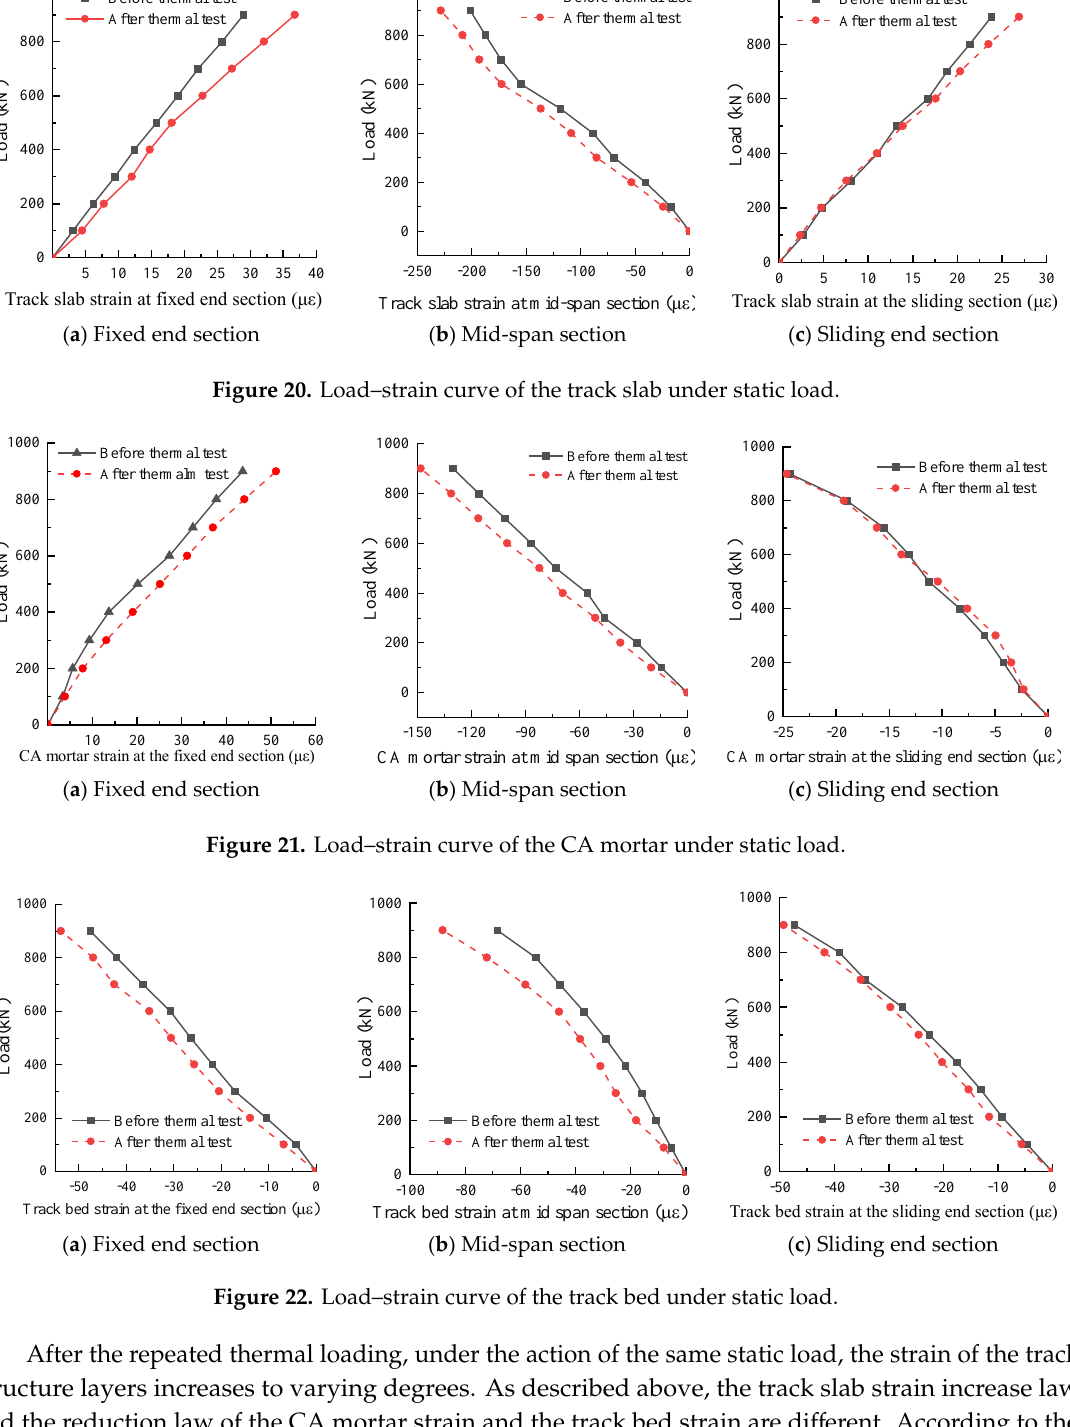
Figure 22. Load–strain curve of the track bed under static load.